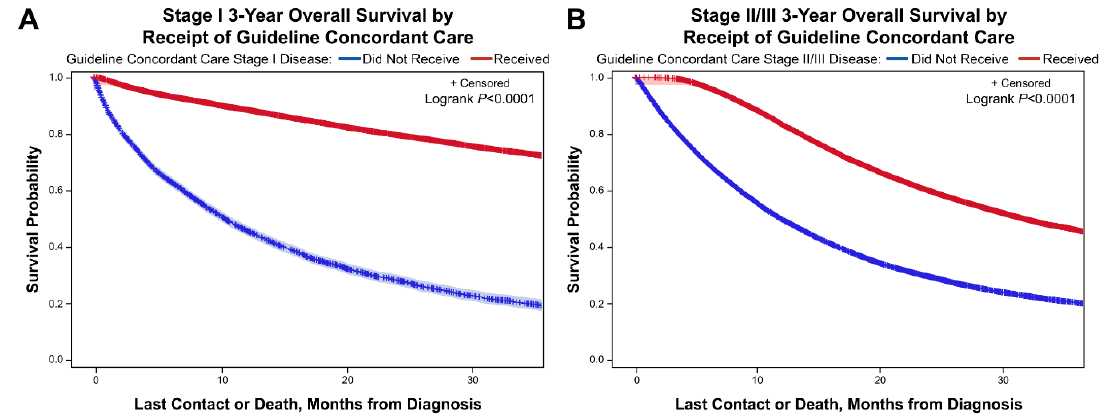
Figure 3. Kaplan-Meier analysis of 3-year overall survival for gastric cancer stratified by receipt or non-receipt of guideline concordant. For Stage I disease ( A ) and Stage II / III disease ( B ) survival is significantly better when patients received stage specific guideline concordant care.